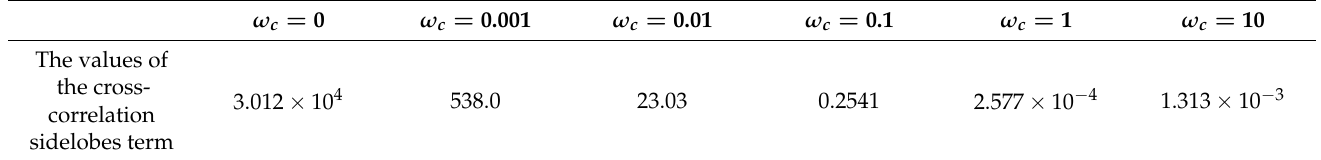
Table 3. The cross-correlation sidelobes term under different values of ω c by the proposed